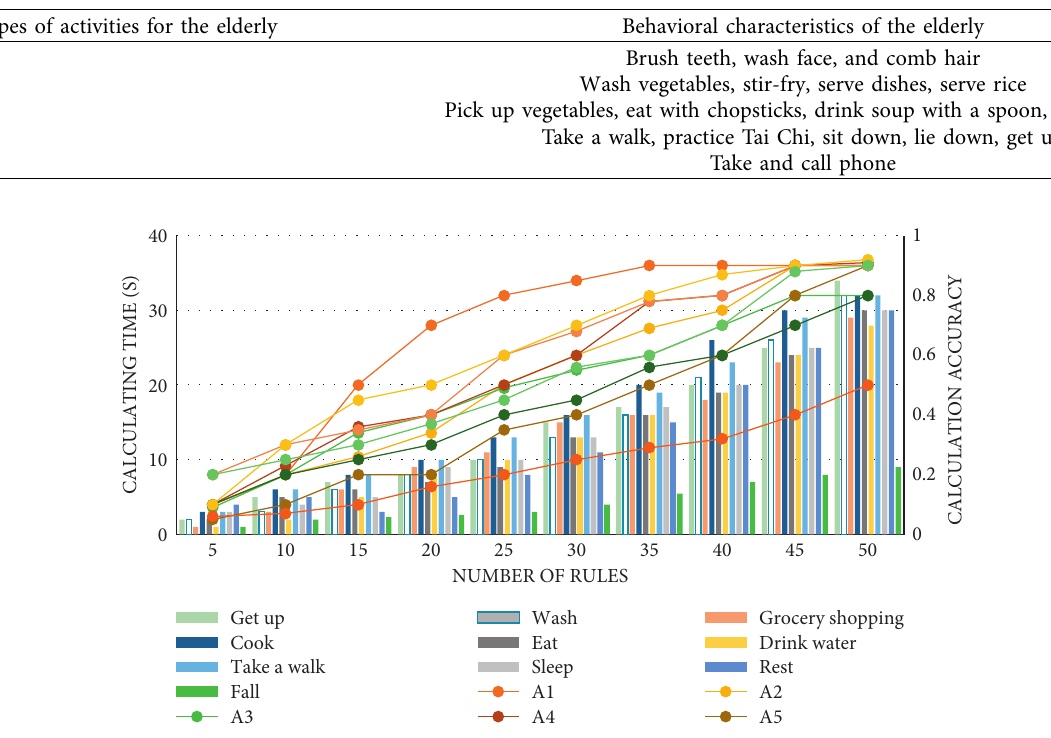
Table 1: Basic behaviors of the elderly at home.